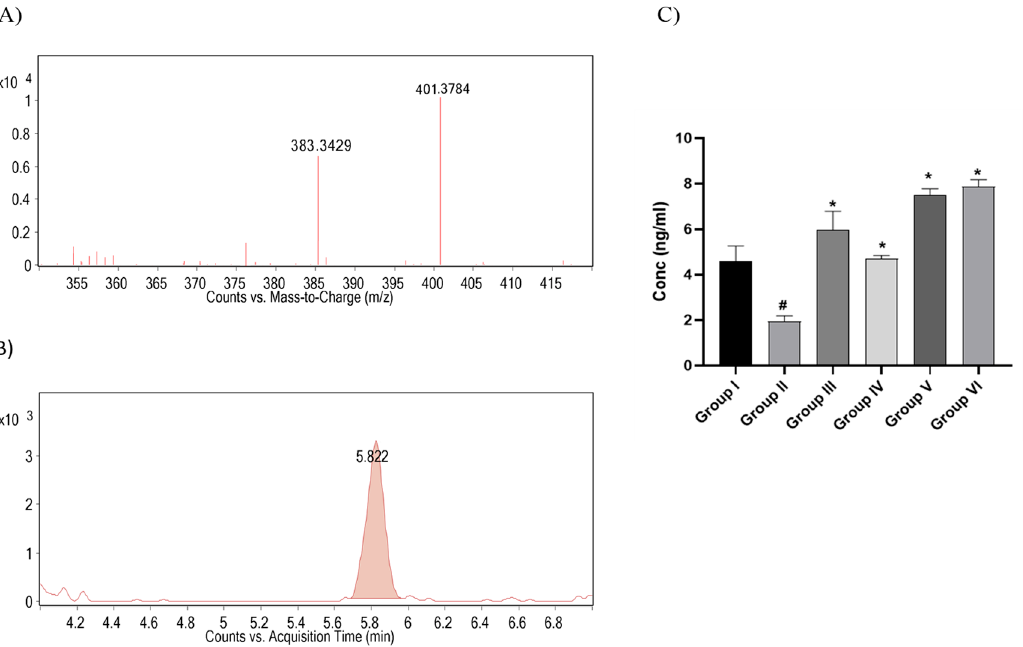
Figure 2. Quantification of 25-OH-D 3 levels by LC-MS/MS. ( A ) Mass fragmentation of 25-OH-D 3 . ( B ) Ion chromatogram of the selected fragment ion ( m / z 383.5 → 401.3). ( C ) Quantification of serum 25-OH-D 3 from the area under the curve (data are expressed as the mean ± SD ( n = 4), analyzed by one-way ANOVA followed by Tukey’s multiple comparison test. # = p < 0.05 is considered statistically significant when comparing group, I vs. group II. * = p < 0.05 is considered statistically significant when compared with the other treatment groups (group III, IV, V, and VI) vs. diet control group).